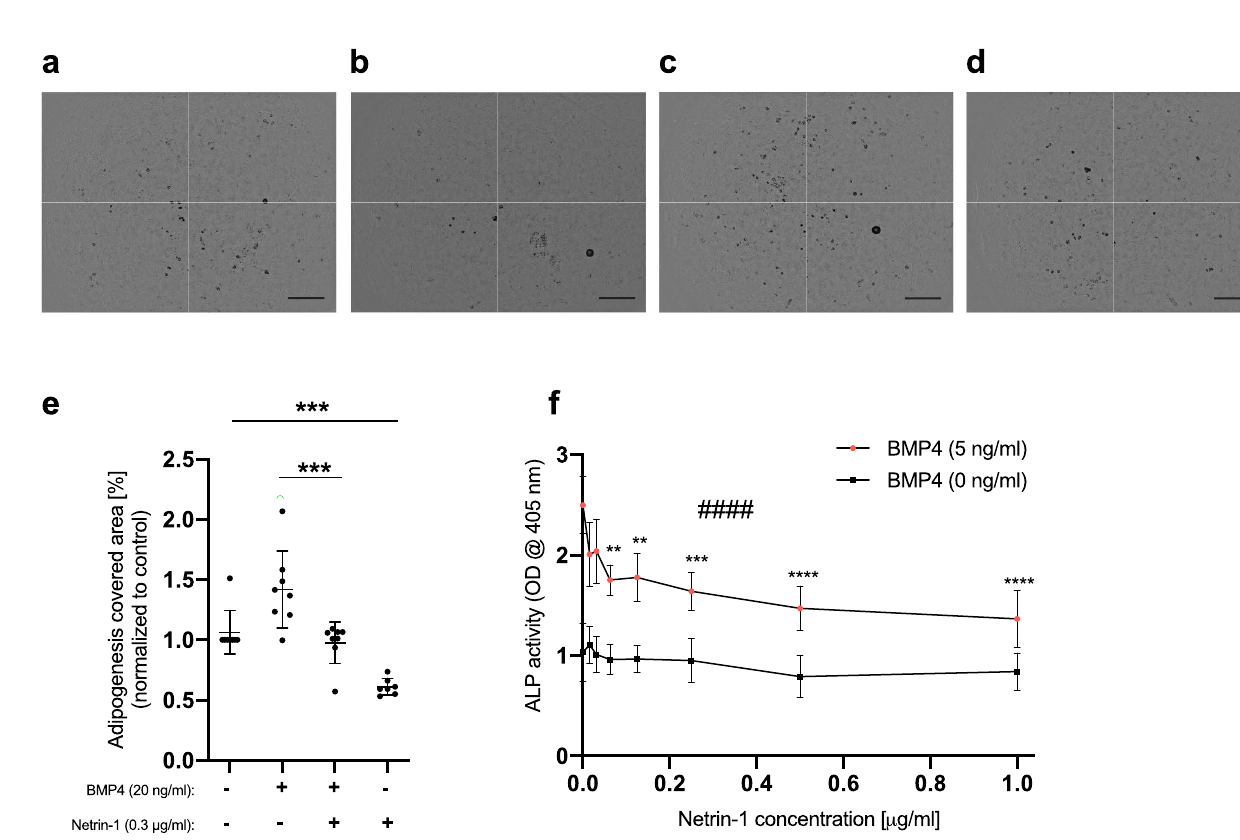
Figure 3. Neogenin is required for netrin-1-induced inhibition of BMP signaling, and its expression levels are regulated by netrin-1 and LRIG proteins. ( a ) Effects of netrin-1 on BMP signaling in Neo1 wild-type ( Neo1 + / + ) and Neo1 -deficient ( Neo1 −/− ) MEFs. The cells were treated with different concentrations of BMP4 in the presence or absence of 0.25 μg/ml netrin-1. Signaling was analyzed using a pSmad1/5 assay. The graph shows the average means with the standard deviations of four biological replicates. ( b ) Neogenin expression levels in MEFs of different genotypes ( Ntn1 + / + or Ntn1 −/− and Lrig -wildtype or Lrig -null [ Lrig1 −/− ; Lrig2 −/− ; Lrig3 −/− ]). Neogenin and actin levels were analyzed by Western blotting. The graph represents the average means with standard deviations of band intensity ratios (neogenin/actin) from four Ntn1 + / + ;Lrig -wild-type biological replicates and three Ntn1 −/− ;Lrig -wild-type or Ntn1 −/− ;Lrig -null biological replicates that were determined with three independent experiments. ( c, d ) Concentration-dependent ( c ) and time-dependent ( d ) effects of netrin-1 treatment on neogenin expression levels in Ntn1 −/− ; Lrig -wild-type and Ntn1 −/− ; Lrig -null MEFs. Representative blots and graphs showing the average means with standard deviations of four independent experiments are shown (one-way ANOVA: # p < 0.05; ### p < 0.001; #### p < 0.0001. Post-hoc test with multiple comparisons [compared to netrin-1, 0 ng/ml] adjusted p-value: ns p ≥ 0.05; *p < 0.05; **p < 0.01; ***p < 0.001; ****p < 0.0001). ( e–g ) Effects of induced expression of LRIG1 ( e ), LRIG2 ( f ), and LRIG3 ( g ) on neogenin expression levels. LRIG expression was induced through the treatment of LRIG-inducible MEFs with 100 ng/ml of doxycycline, overnight. Neogenin and actin levels were analyzed using Western blotting. Uncropped blots are shown in Fig. S7. Representative blots and graphs representing average means with standard deviations of four independent experiments are shown. (Student’s t -test; *, p < 0.05; **, p < 0.01; ***, p < 0.001. Colors of asterisks in ( a ) represent the respective genotype, according to the graph symbols, compared to Neo1 + / + ).